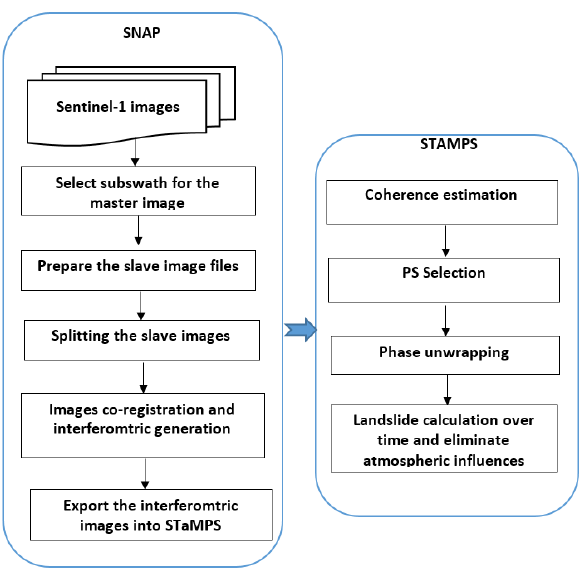
Figure 3. PSInSAR data processing flow chart using SNAP and StaMPS.